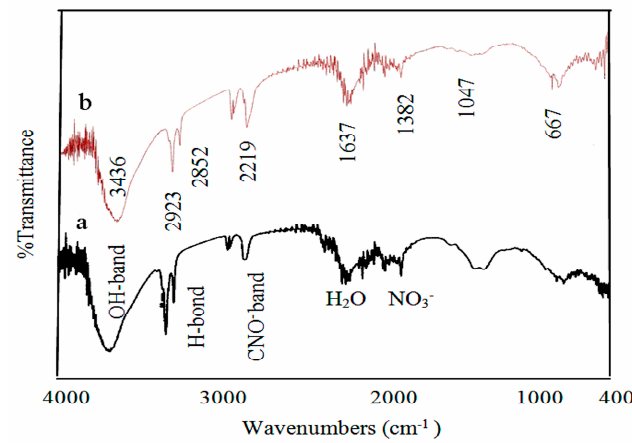
Figure 8. Infrared spectra of Co–Si LDHs: ( a ) after zirconium inclusion and ( b ) after zirconium and titanium inclusion.